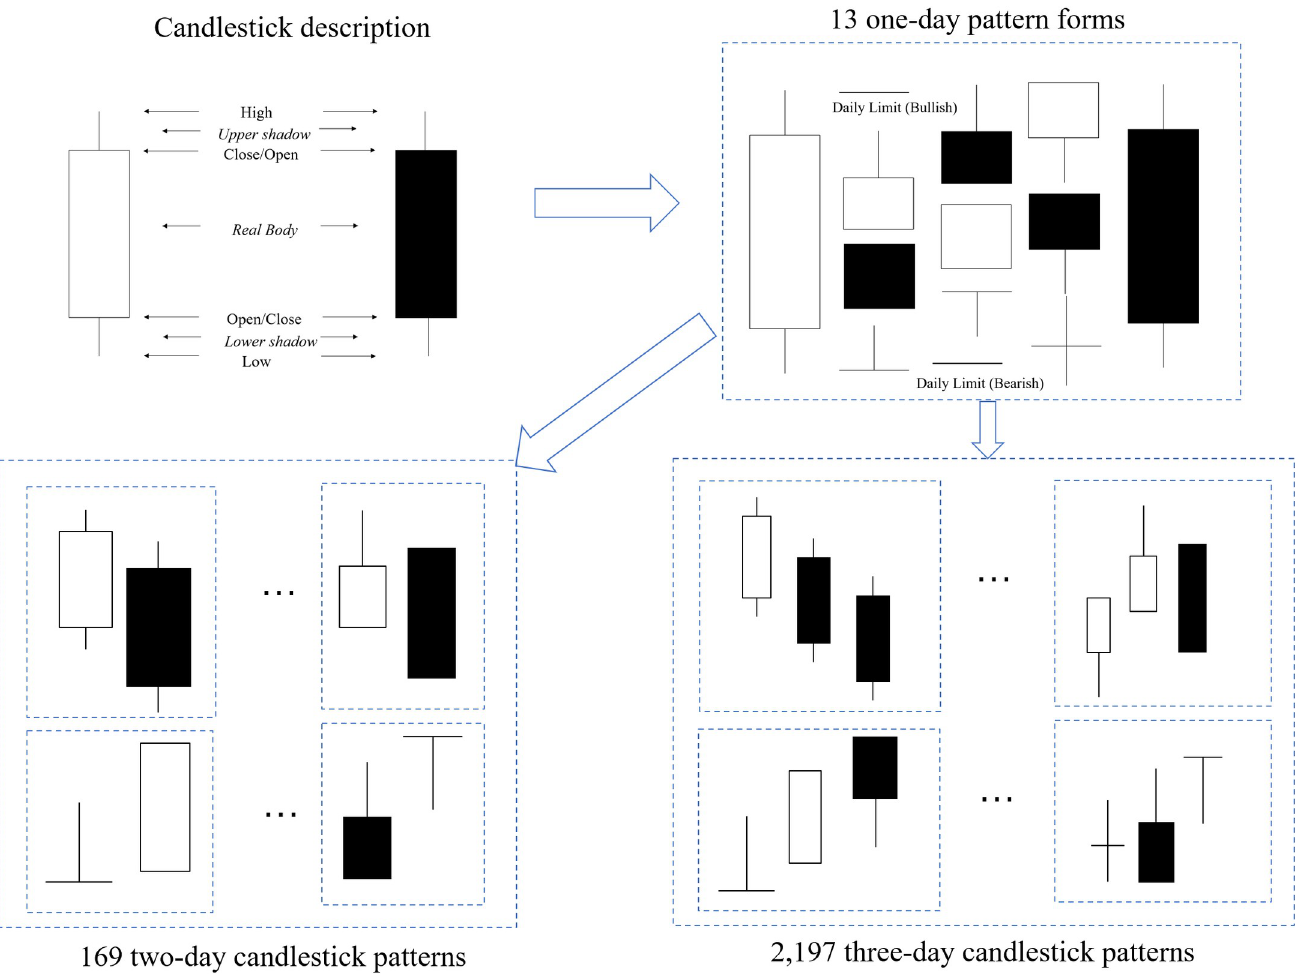
Fig 3. Description of a candlestick and candlestick